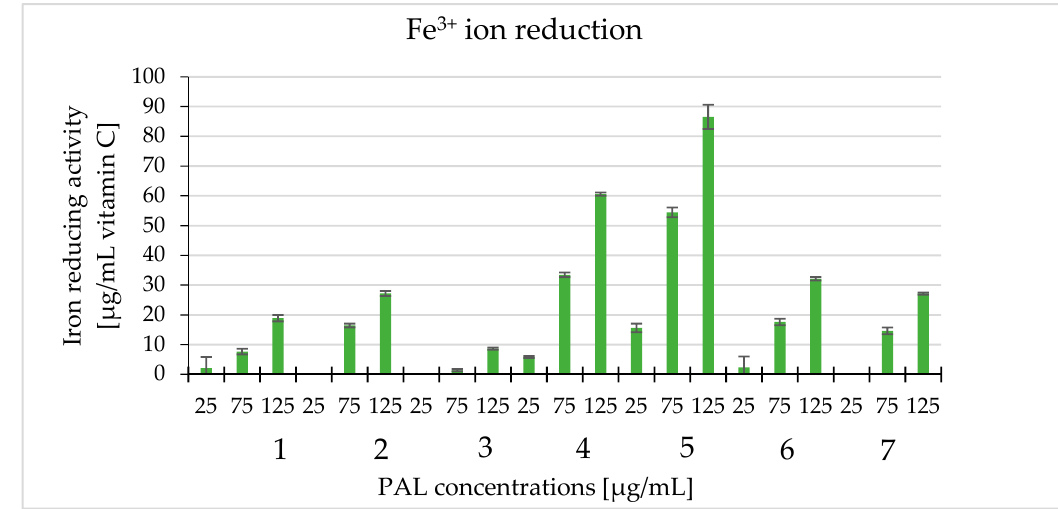
Figure 6. The ability to reduce iron ions of the tested extracts (PAL1–PAL7) at the concentrations 25, 75, and 125 µ g / mL with the ferric reducing antioxidant power (FRAP) method and expressed as vitamin C equivalents ( µ g / mL).